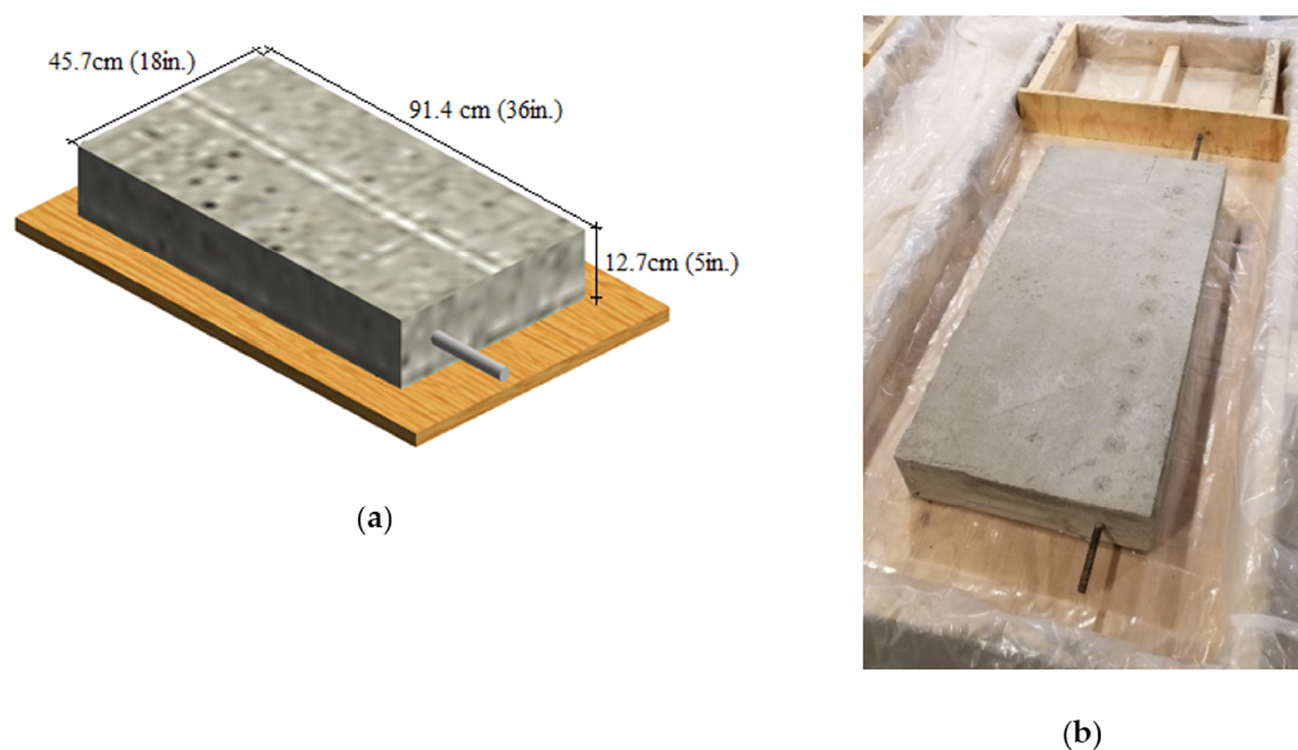
Figure 2. Test specimens: ( a ) illustration with dimension; ( b ) actual specimen before submersion.